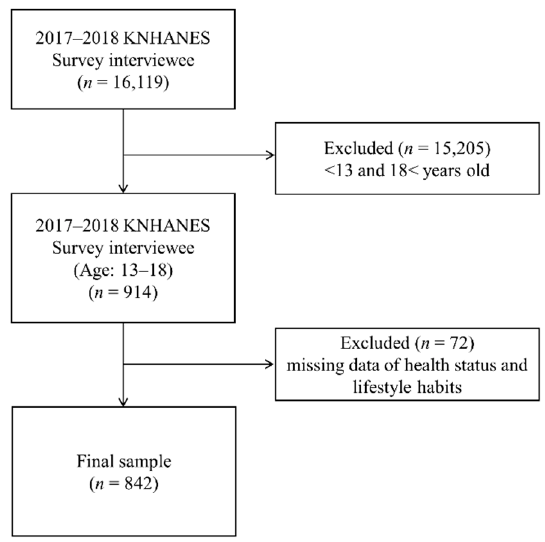
Figure 1. Flowchart of study sample.